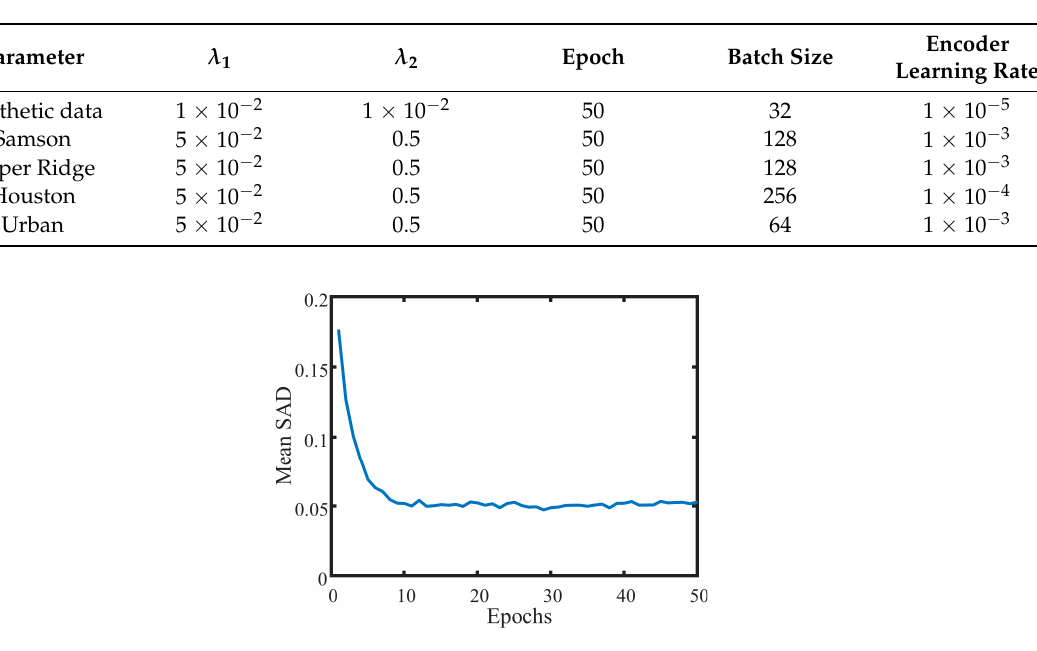
Figure 7. Convergence curves during 50 epochs.